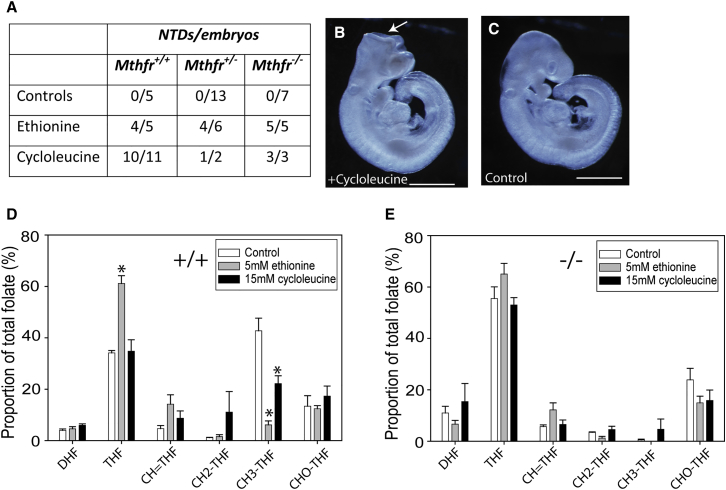
Methionine Cycle Inhibitors Cause NTDs without Imposition of a Methyl Trap(A–C) Treatment in whole-embryo culture with ethionine (5 mM) or cycloleucine (15 mM) caused NTDs among embryos of all Mthfr genotypes (A). NTDs affected the cranial region (open midbrain-forebrain neural folds in cycloleucine-treated embryo; arrow in B), whereas closure was completed during the culture period in vehicle-treated controls (C). Scale bar represents 1 mm.(D) In Mthfr+/+ embryos, ethionine treatment resulted in a significant increase in relative abundance of THF. Both ethionine and cycloleucine caused a decrease in relative abundance of 5-methyl THF compared with controls (∗p < 0.01, ANOVA).(E) In cultured Mthfr−/−embryos, abundance of folate intermediates was not significantly affected by ethionine or cycloleucine, and, as in non-cultured embryos, the relative abundance of THF and 5-methyl THF differed from Mthfr+/+ embryos (compare with D, p < 0.001, two-way ANOVA).In (D) and (E), n = 3–5 samples per genotype for each treatment